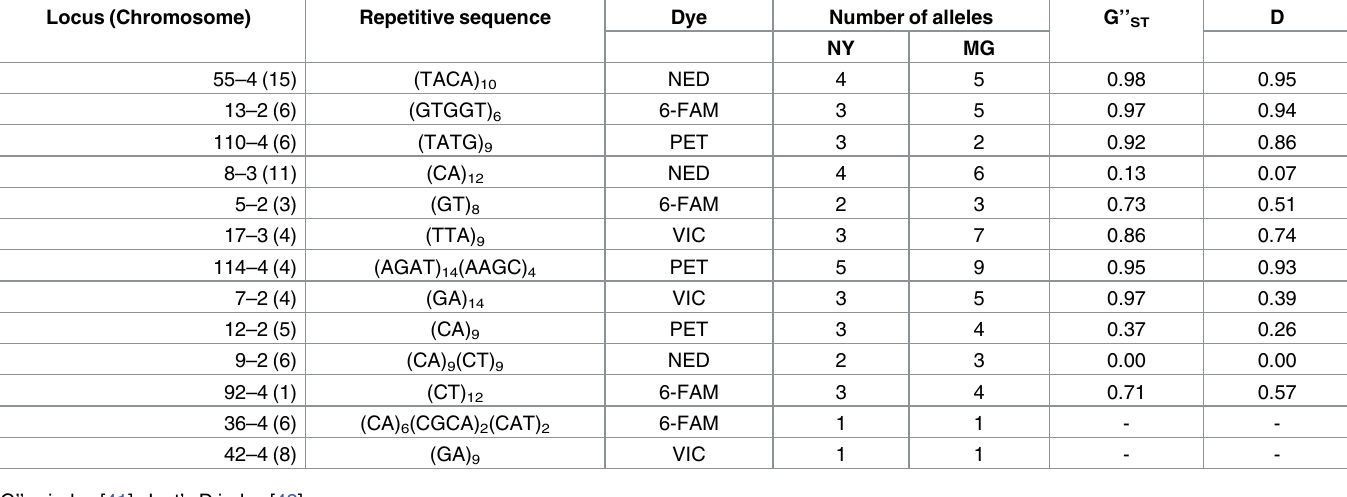
Table 1. Number of alleles and genetic differentiation per locus between the Sclerotinia sclerotiorum populations from New York (NY), USA and Minas Gerais State (MG), Brazil. Estimates were obtainedfor 13 SSR loci located in eight distinct chromosomes. Locus (Chromosome) Repetitive